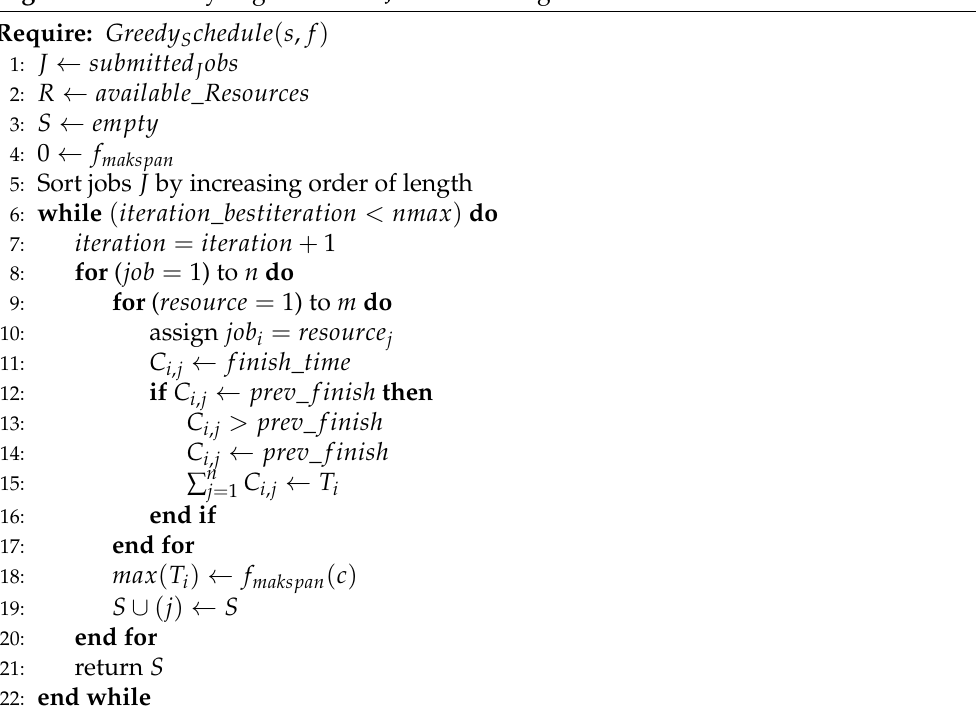
Algorithm 1 Greedy Algorithm for Job Scheduling.